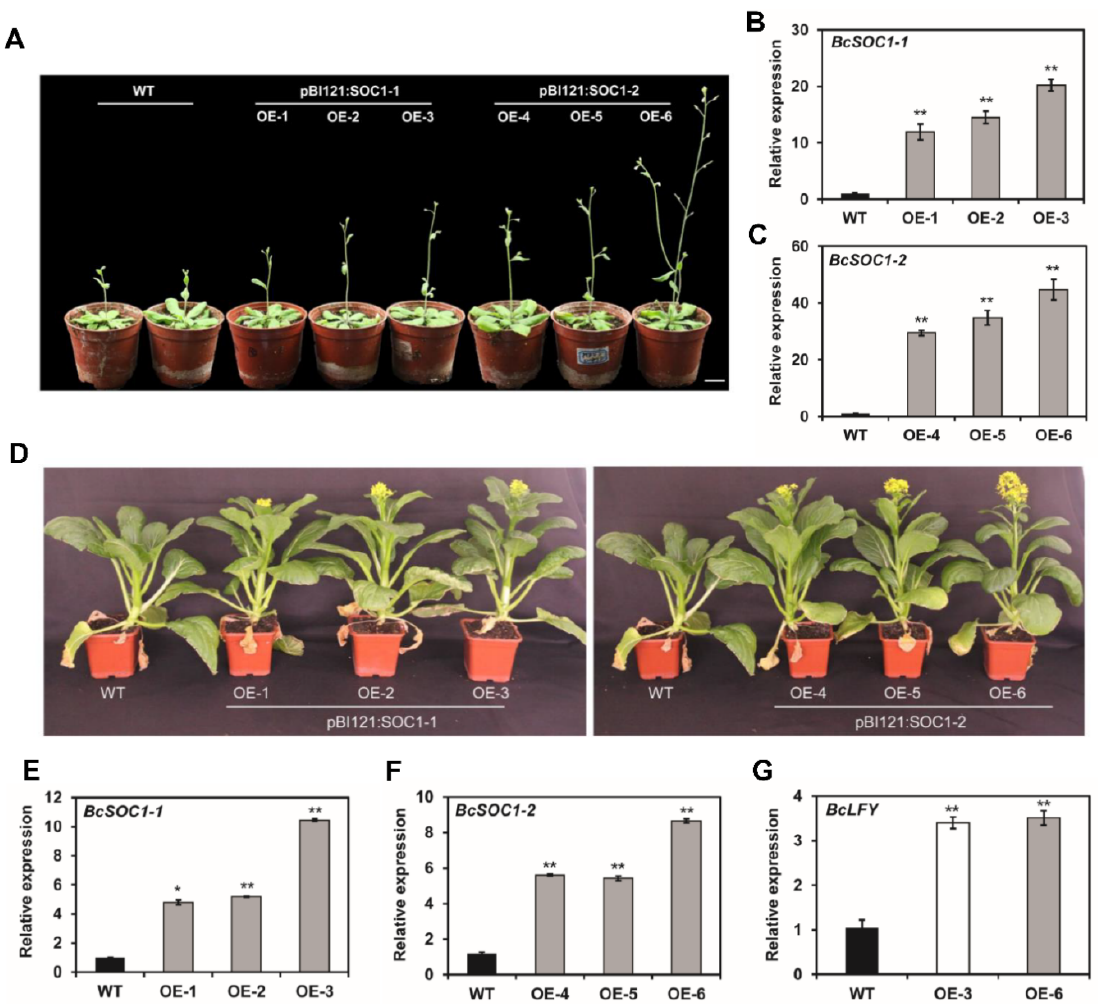
Figure 3. Overexpression of BcSOC1 in Arabidopsis and flowering Chinese cabbage. ( A ) Ectopic expression of BcSOC1 accelerated early flowering phenotype in Arabidopsis . Bar = 2 cm. ( B , C ) Expression analyses of BcSOC1 ‐ 1 and BcSOC1 ‐ 2 using qRT ‐ PCR in wild type (WT) and overexpression lines. ( D ) Phenotypic characterization of the WT and pBI121: BcSOC1 transgenic lines. Bar = 2 cm.